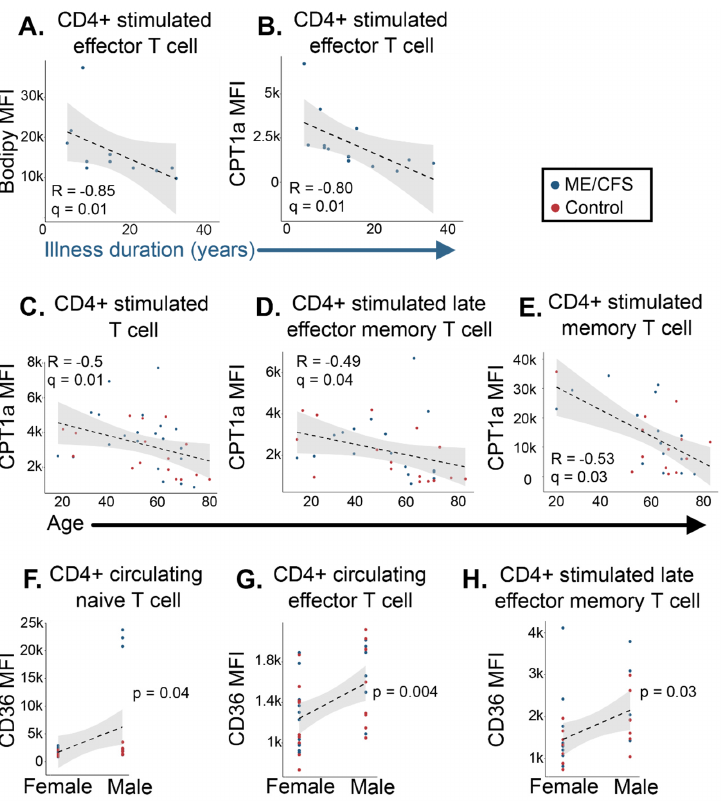
Figure 7. CD4+ T cell fatty acid oxidation markers correlate with survey data in patients with ME/CFS and healthy controls. Significant correlations between subject information and CD4+ T cell fatty acid oxidation data. Plots of correlations between ( A ) stimulated effector T cell Bodipy ( n = 11) and ( B ) CPT1a ( n = 13) MFI vs. duration of illness; ( C ) stimulated total ( n = 16 healthy control sam- ples, n = 20 ME/CFS samples [ n = 16/20]), ( D ) late effector memory ( n = 16/17), and ( E ) memory ( n = 13/15) CPT1a MFI vs. age, and ( F ) circulating naïve ( n = 12 healthy control samples, n = 19 ME/CFS samples, and n = 17 females, n = 14 males [ n = 12/19, 17/14]), ( G ) circulating effector ( n = 19/20, 22/17), and ( H ) stimulated late effector memory ( n = 16/14, 18/12) CD36 MFI vs. sex. For correlations ( A − E ), a Spearman’s correlation test with FDR-based multiple testing correction was performed, where a q value of less than 0.05 was considered significant. For correlation testing between sex ( F − H ), a Pearson’s product − moment correlation was used, where a p − value of less than 0.05 was considered significant. 3. Discussion Previous studies have linked lymphocyte dysfunction to ME/CFS, particularly in T and NK cell populations. Immune system involvement in ME/CFS is comprised of changes in cytokines, a diminished cytotoxic immune response, poorer proliferative ca- pabilities, and patient symptoms, such as inflammation and flu-like instances, that reflect immune impairment [3]. Meanwhile, plasma metabolomic studies in ME/CFS consistently report altered lipid abundances in ME/CFS [28,30–35]. Studies from our lab have previ- ously reported an increased abundance of two carnitine compounds and significant